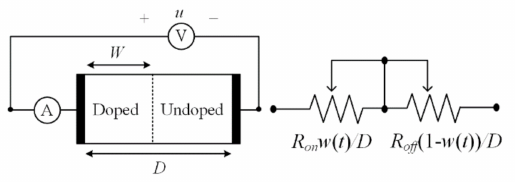
Figure 3. Schematic diagram of HP